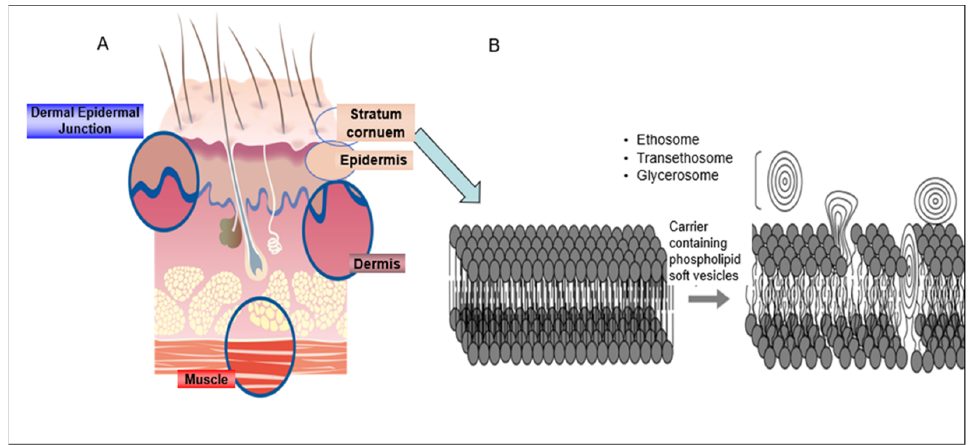
Figure 1. Schematic illustration of ( A ) the skin structure ( B ) the mechanism of action of carriers containing phospholipid soft vesicles.